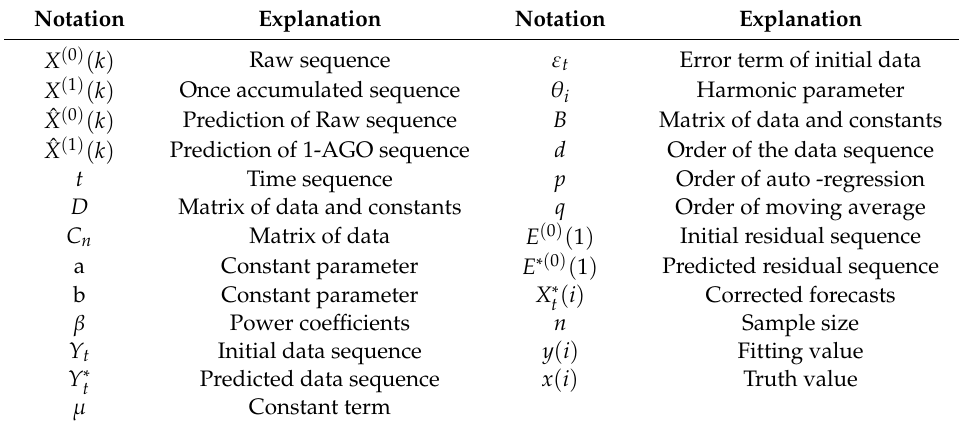
Table 1. Meaning of the symbols in the